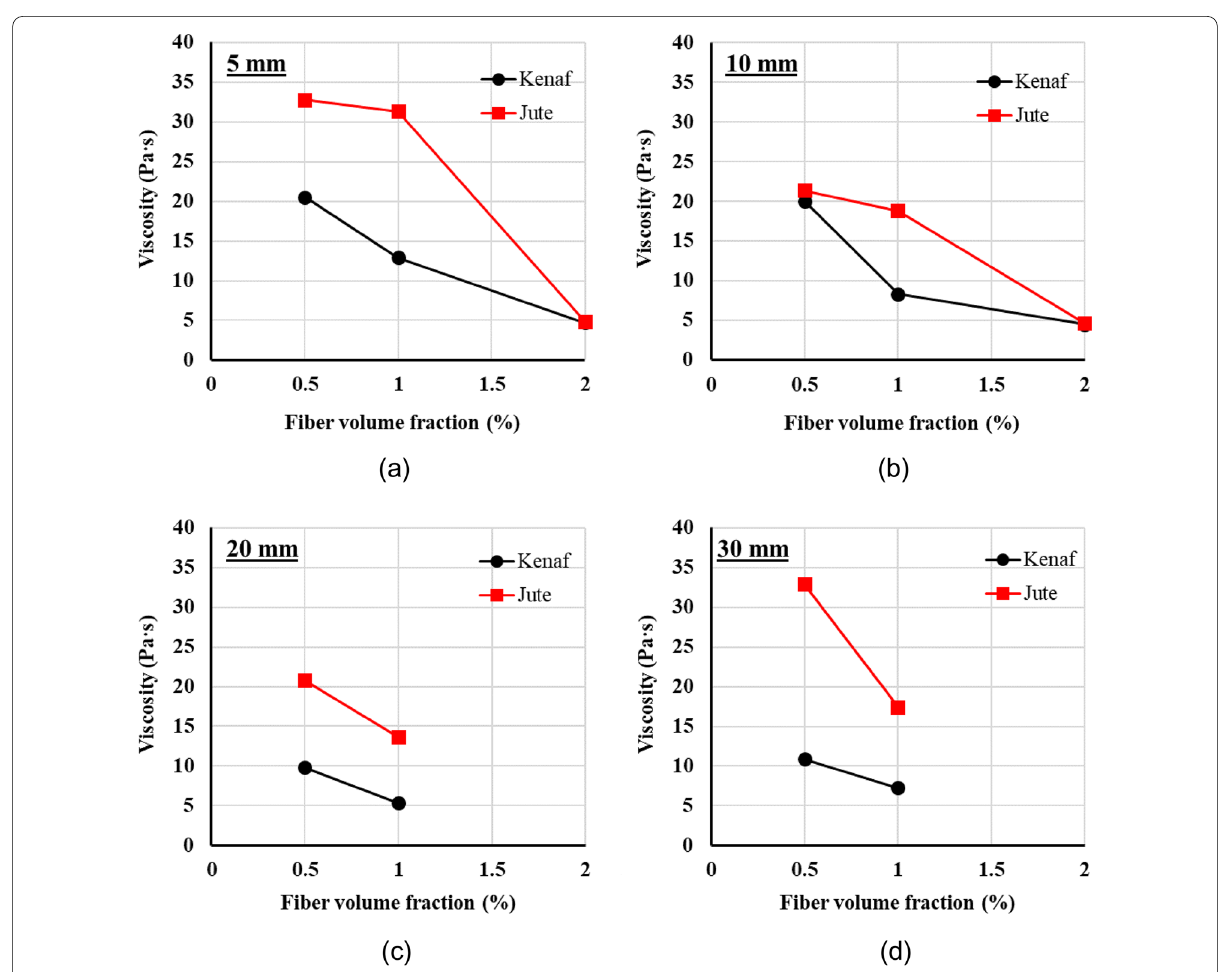
Fig. 11 Plastic viscosity of NFRCCs versus the volume fraction of fibers of different lengths: a 5 mm; b 10 mm; c 20 mm; d 30